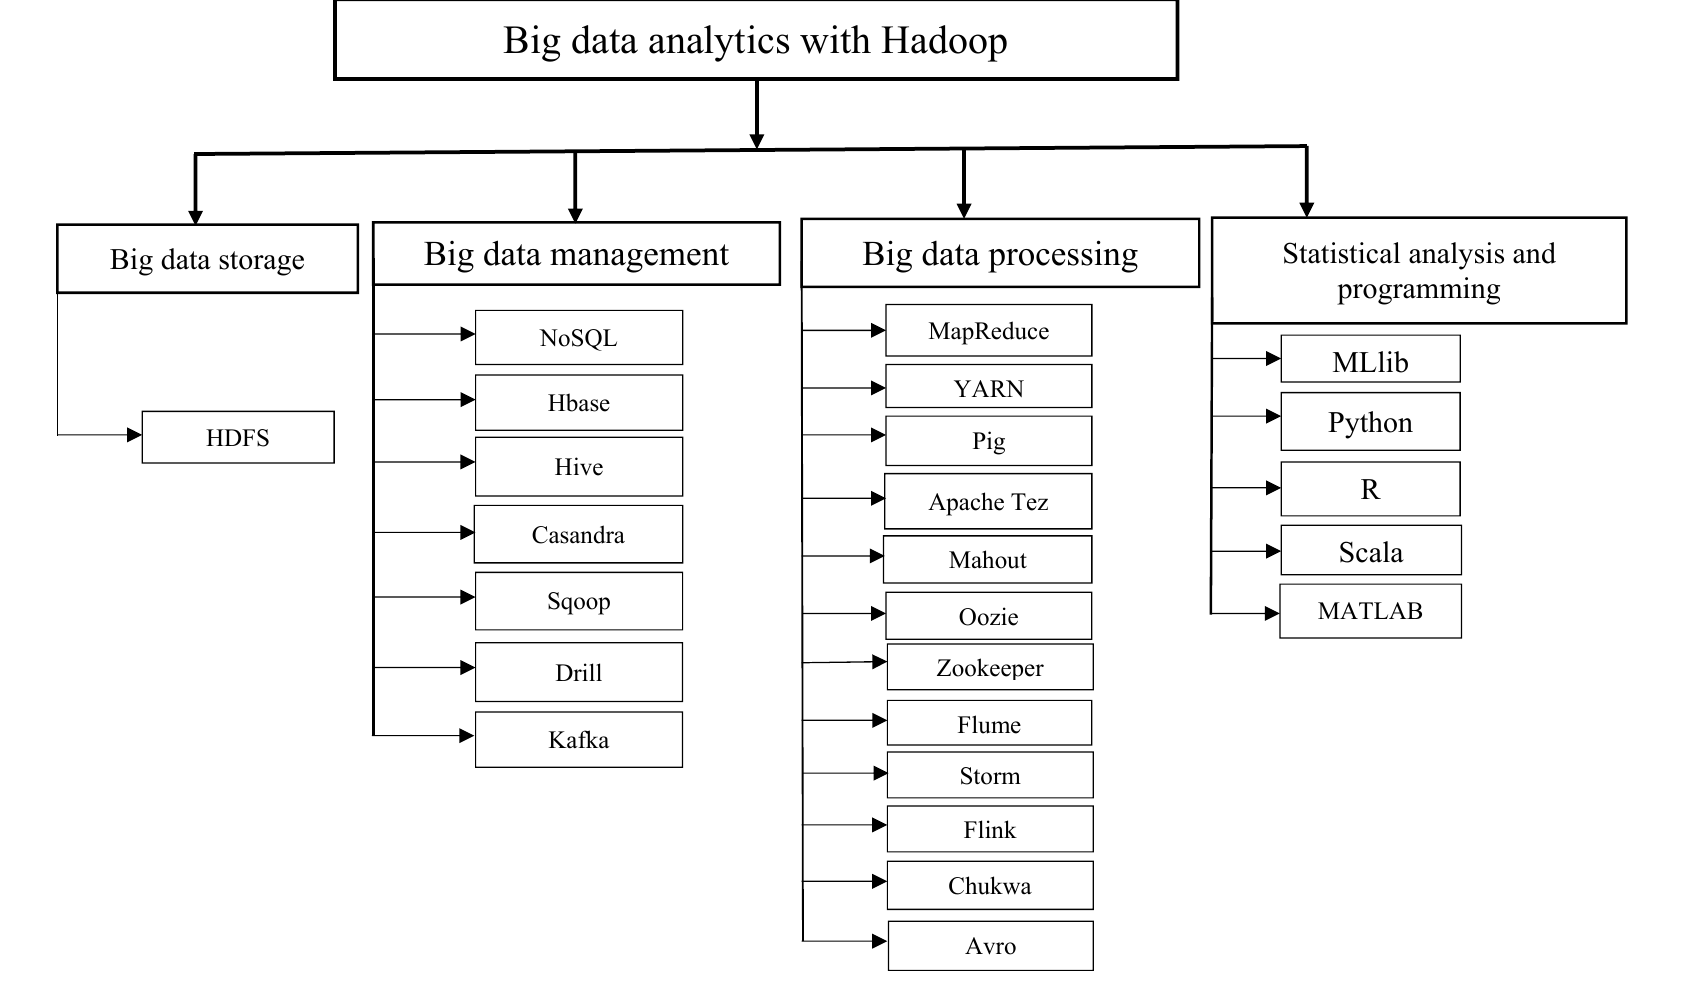
Figure 6. Overview of big data and business analytics in Hadoop.